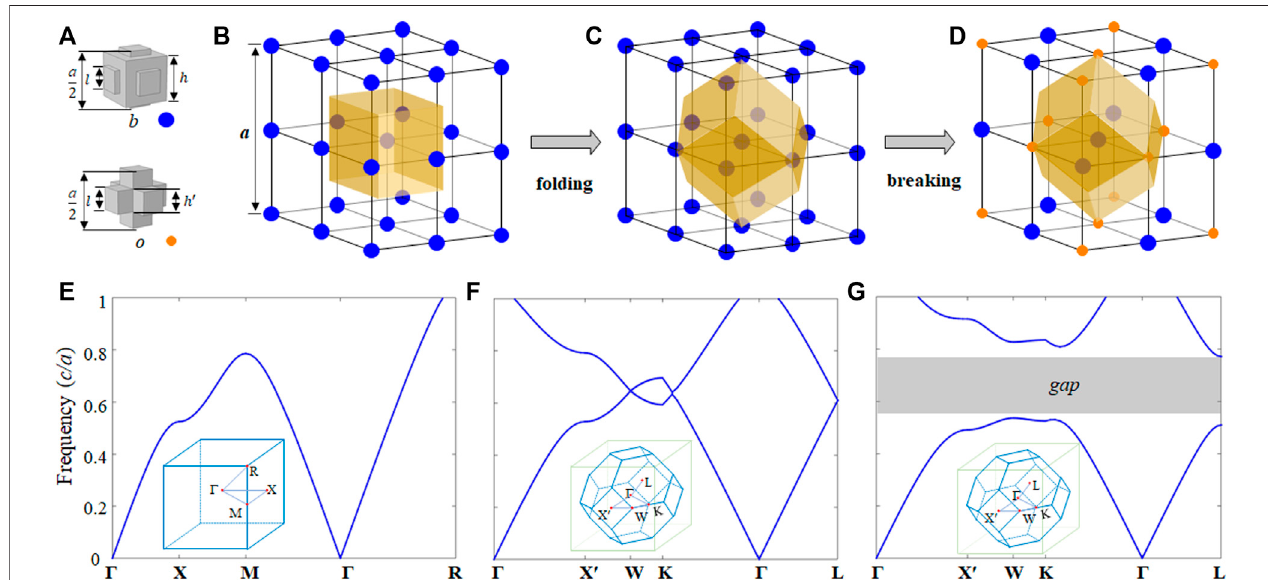
FIGURE 1 | Band folding and breaking in a 3D AC. (A) Two different acoustic atoms b (blue ball) and o (orange ball) with air cavity-tube structures. The structure parametersare h (cid:1) 0.4 a , l (cid:1) h ′ (cid:1) 0.2 a (B) Simplecubicstructurewithidentical b atoms,wheretheprimitiveunitcelliscubicstructuredenotedbyyellowarea (C) Doubling case with the unit cell enlarged to a rhombic dodecahedral shape (D) Breaking the a /2 spatial translation symmetry by replacing the nearest neighbors with o atoms. (E – G) Bulk band structures corresponding to (B – D) , where the insets show the fi rst BZs.